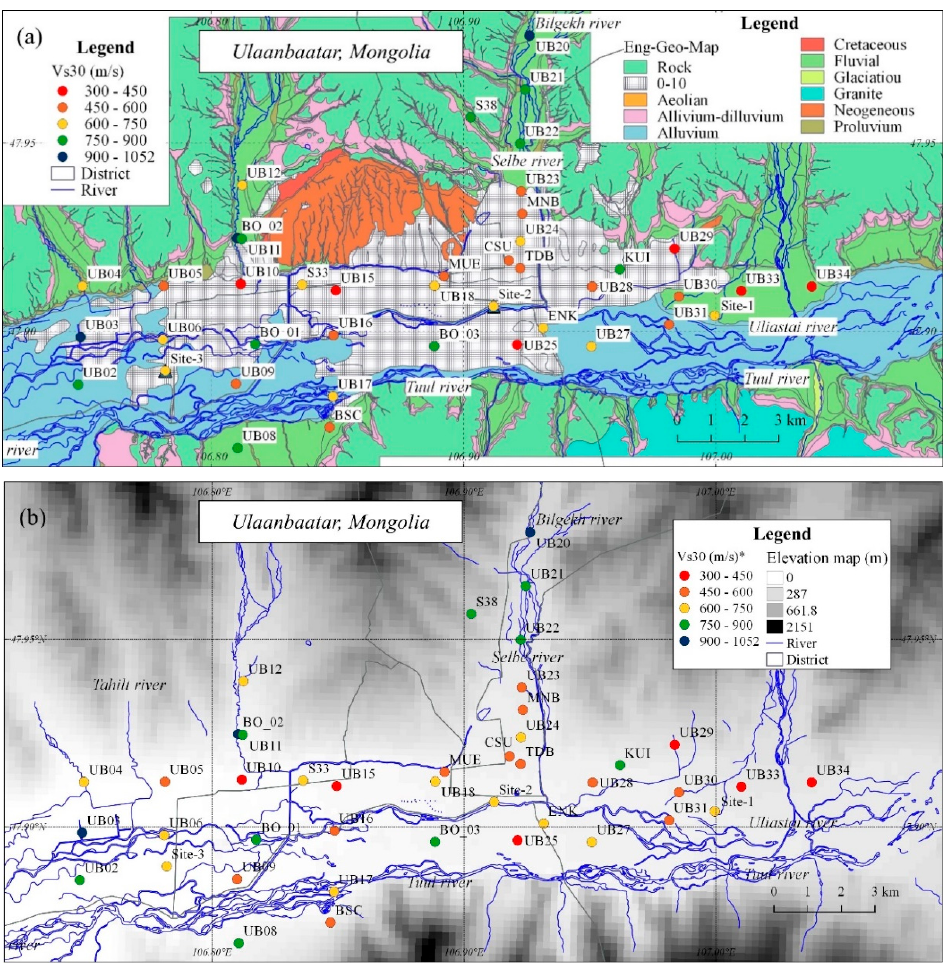
Figure 9. ( a ) V S 30 distribution map with geotechnical map [18]; ( b ) V S 30 distribution map with a digital elevation model